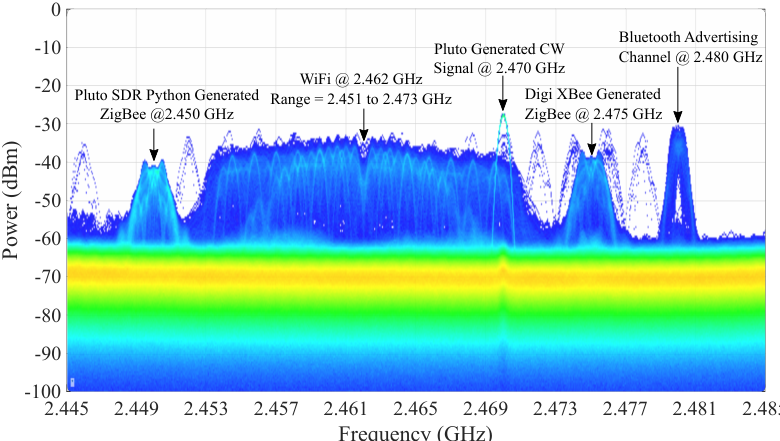
Figure 2. DPX visualization of noise, ZigBee (commercial node), ZigBee (Pluto SDR), CW (Jammer) and coexistence with Bluetooth and